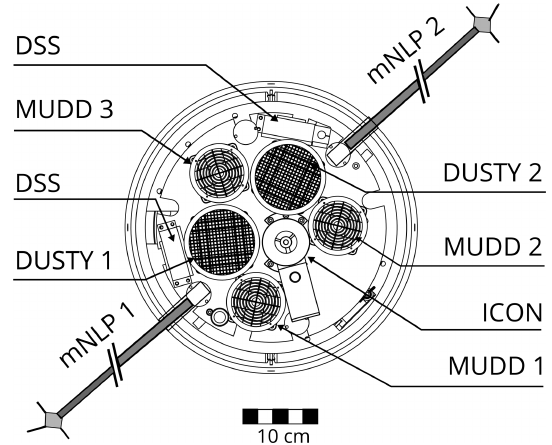
Figure 3. Layout of the top deck and mNLP booms on the MXD-1B payload. The two identical DUSTY probes have a distance between them of 10cm from centre to centre. The length of the booms was ∼ 60cm, with the aim to minimize aerodynamic and electric adverse effects from the main payload structure.